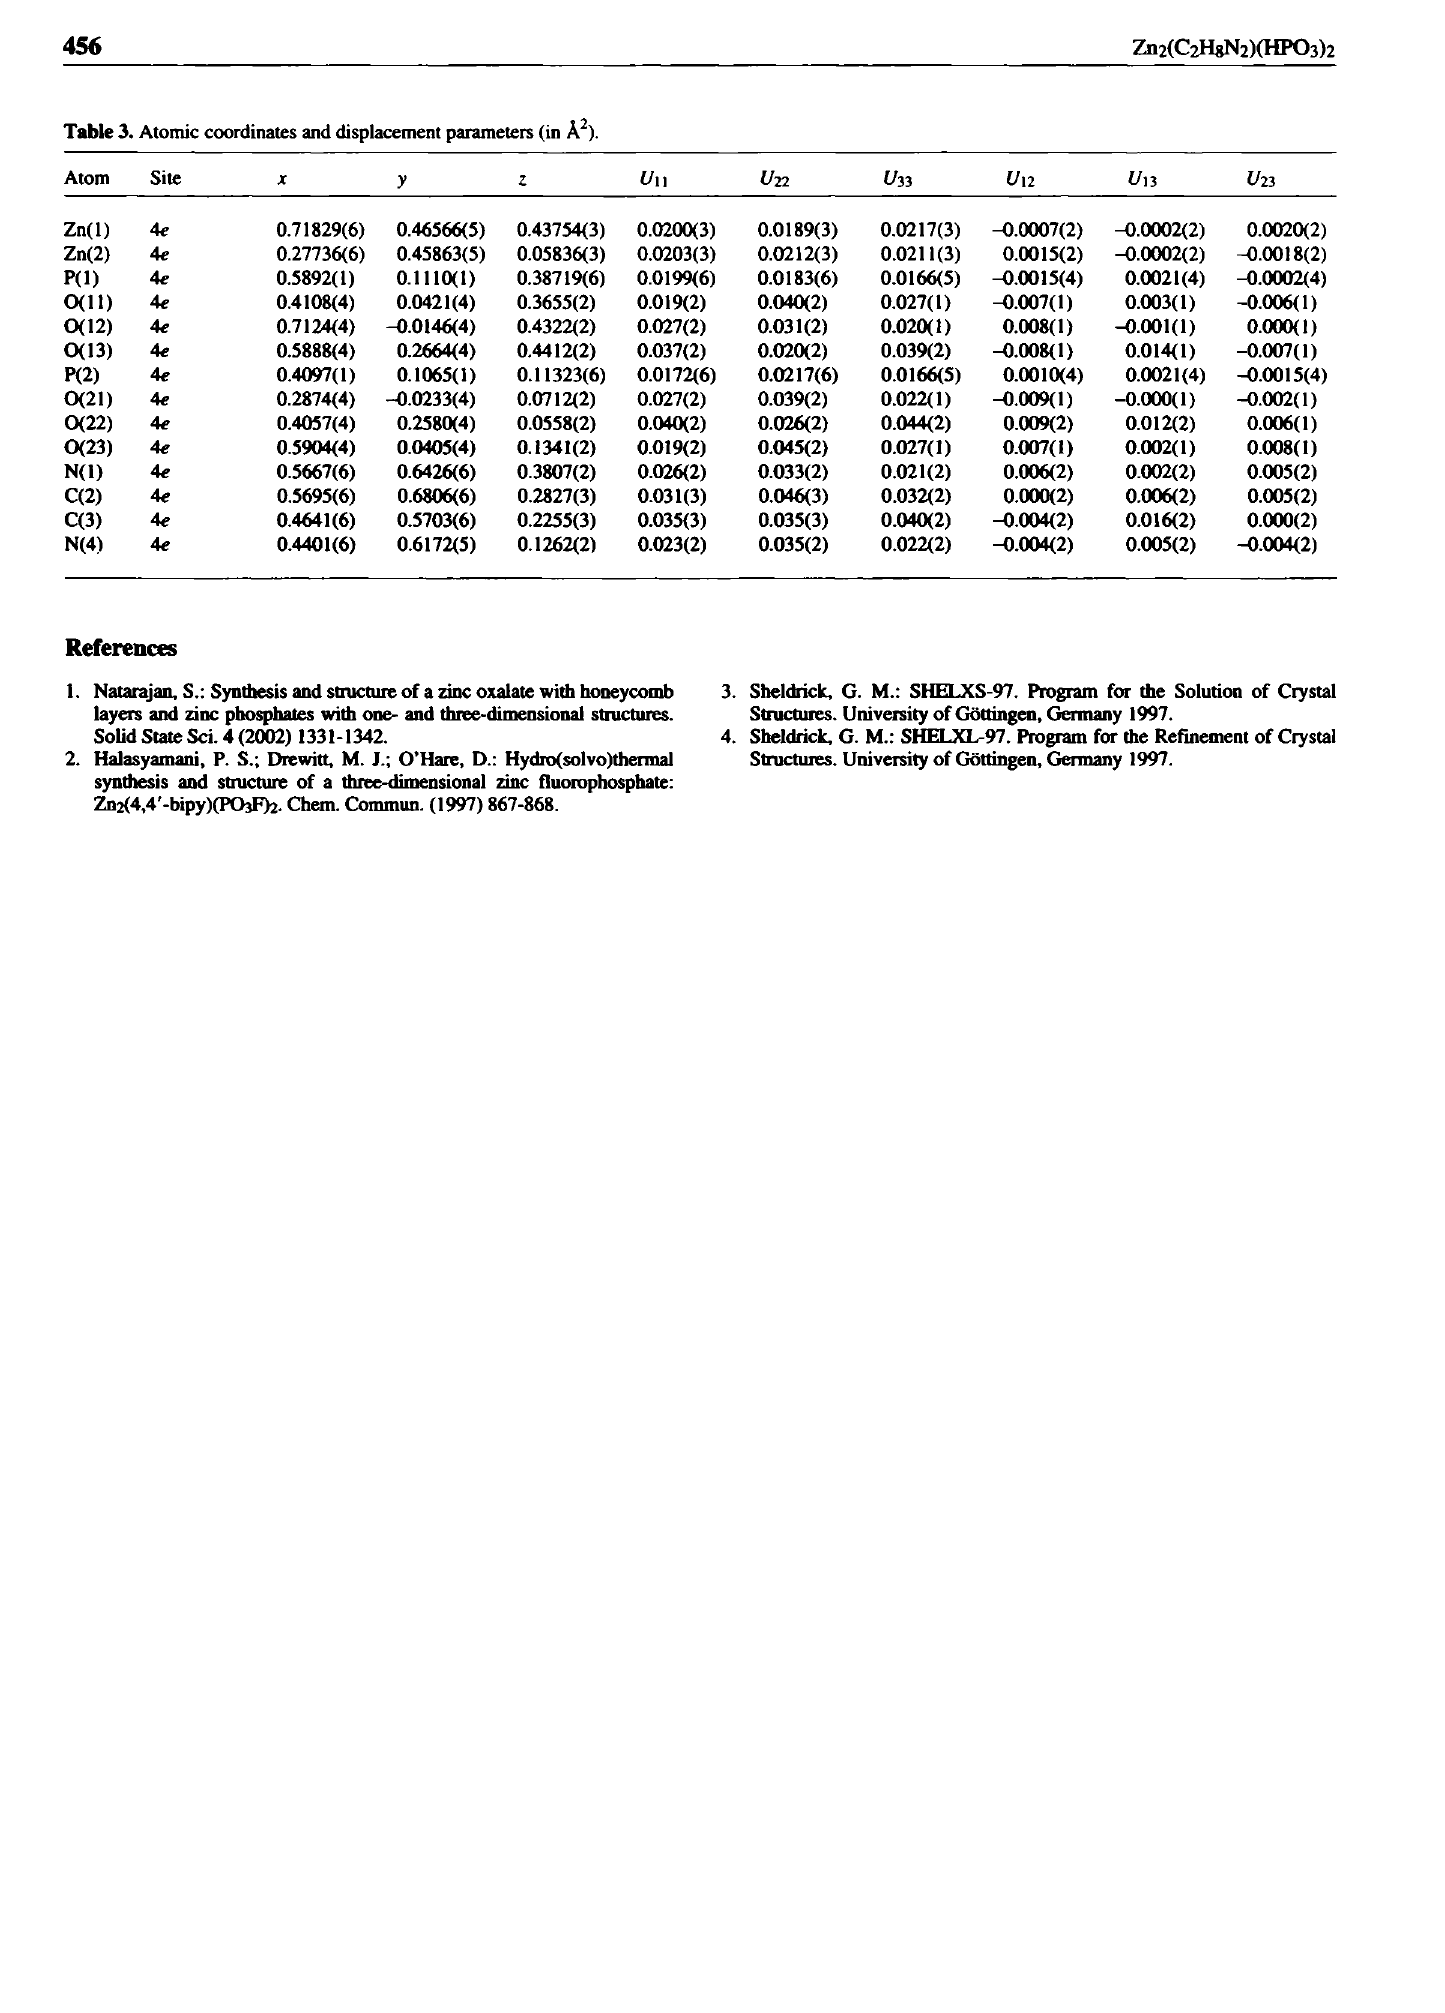
Table 3. Atomic coordinates and displacement parameters (in A 2